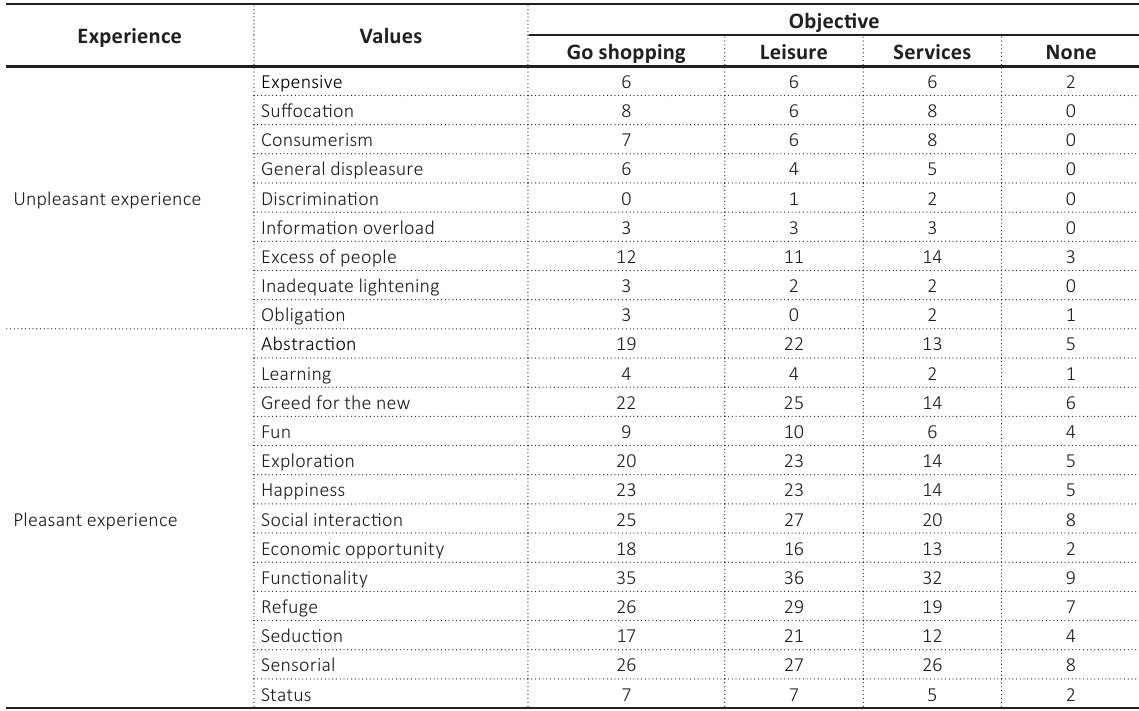
Table 4. Purpose of Shopping Centre visit and positive or negative experiences (number of participants)